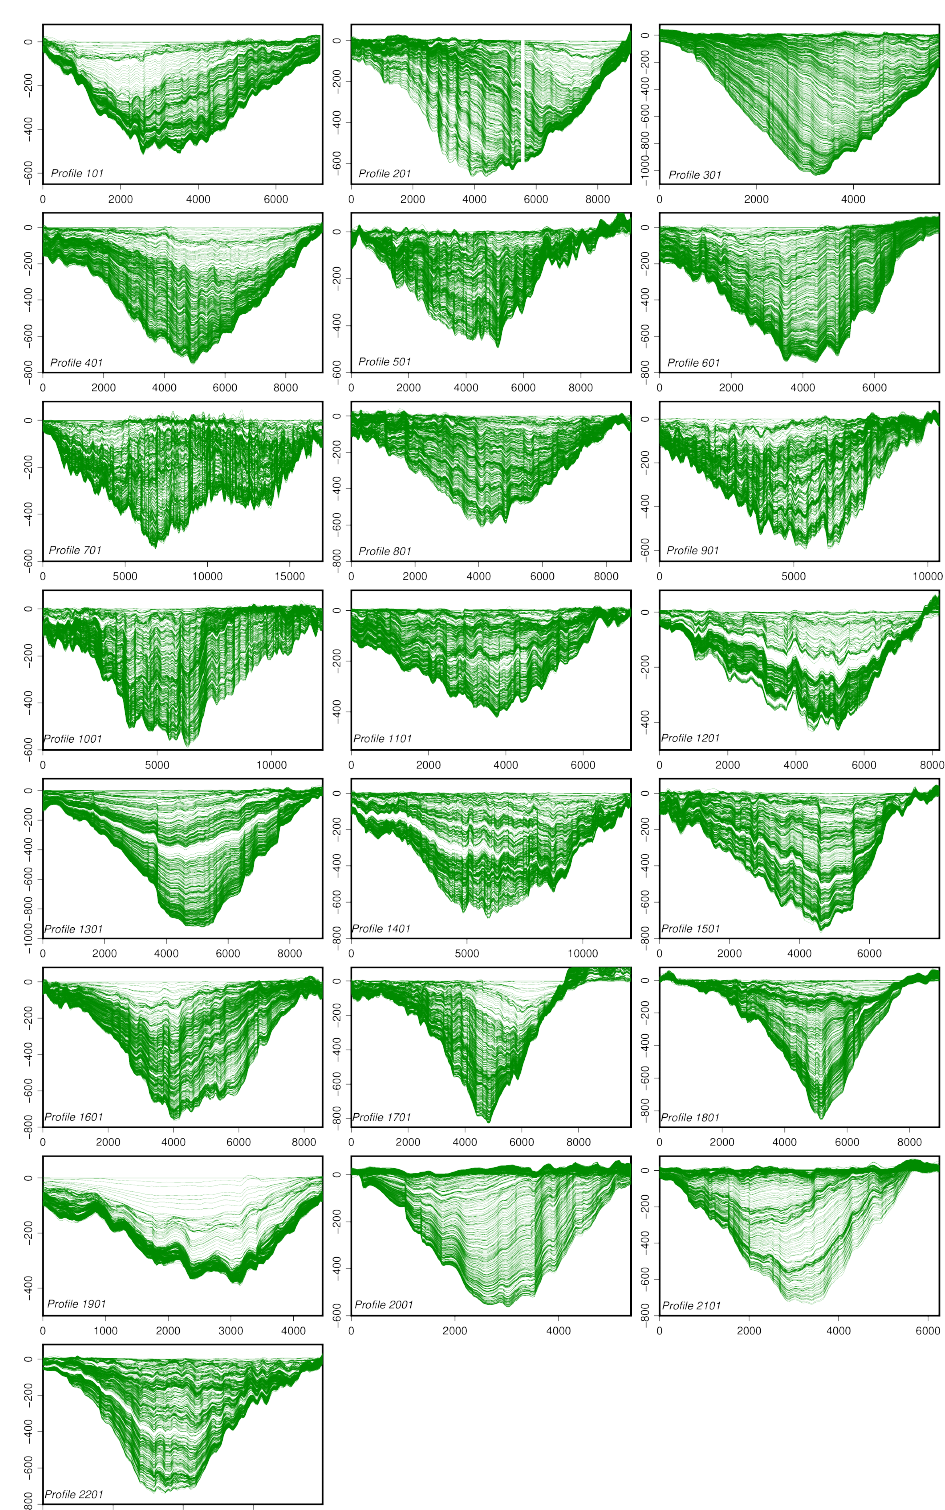
Figure 5. Results of ground surface displacement calculations performed with the SBAS method from November 2014 to July 2021. The presented results apply to horizontal profiles indicated in Figure